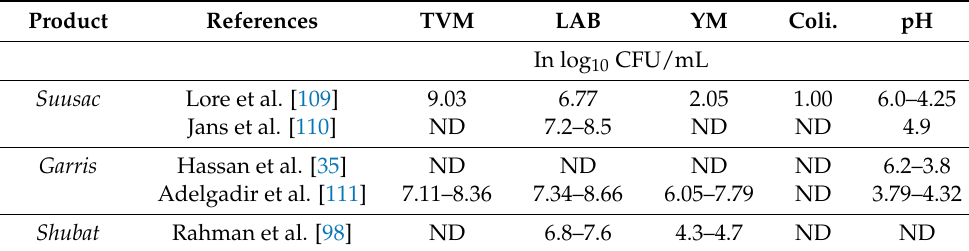
Table 2. Some main characteristics of fermented camel milk from different